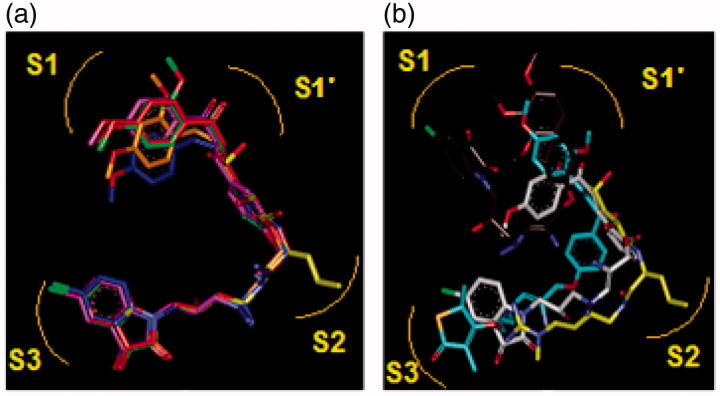
(a) Superposition of most active training set HLClC inhibitors in bound conformation to crystallographic E64 (E64-RX: yellow; HLCIC1: green; HLCIC2: red; HLCIC7: violet; HLCIC13: blue; HLCIC14: orange). (b) Same superposition of less active training set HLClC (E64-RX: yellow; HLCIC4: white; HLCIC8: cyan; HLCIC6: brown).